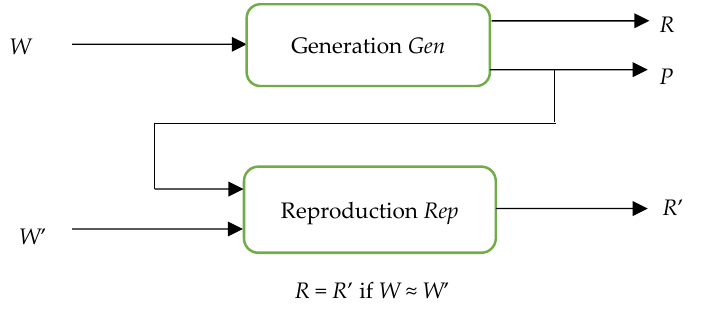
Figure 2. Fuzzy extractor.